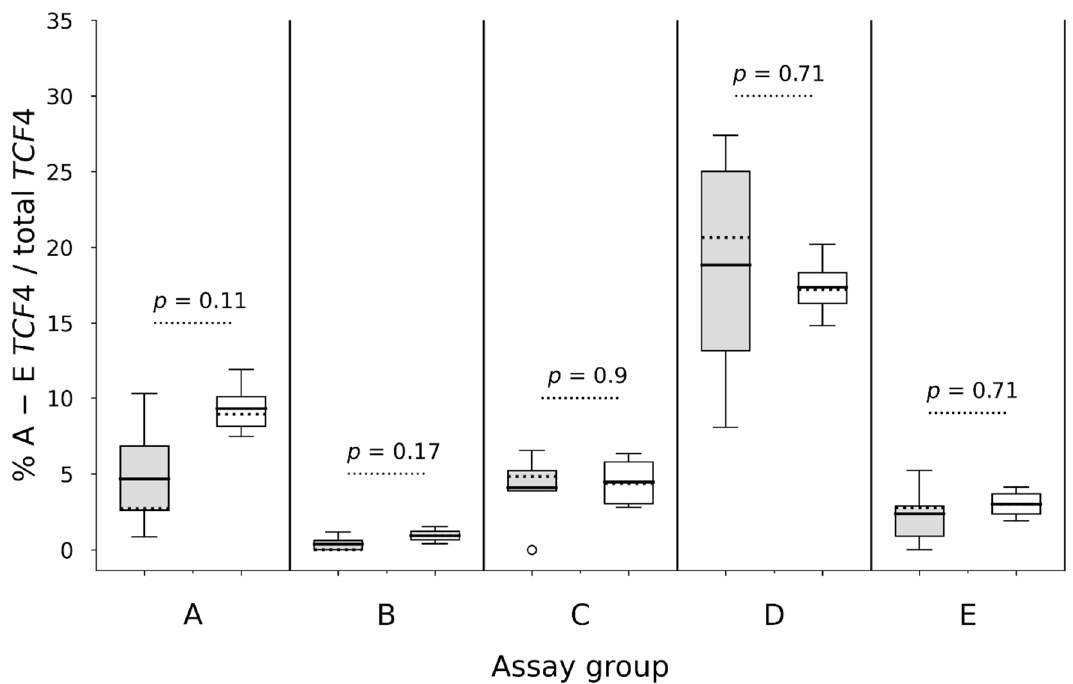
Figure 3. mRNA gene expression by TaqMan TM assays ( A ) to ( E ) targeting TCF4 transcripts ( n = 32) spanning over the (CTG) n repeat ( A – D ) and transcripts starting immediately at the 3 ′ end of the repeat ( E ) in FECD TCF4 + CE (grey) and non-FECD TCF4 − CE (white). Within boxes, dotted lines display medians and continuous lines display means. Empty circles display outliers.